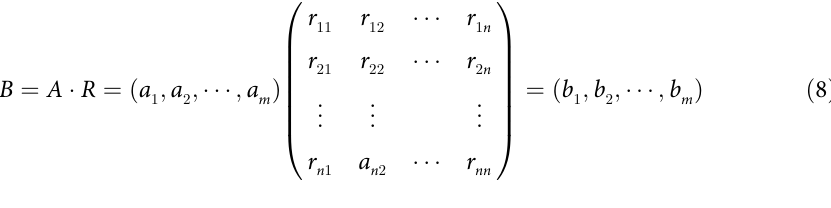
grade on the whole [36]. j